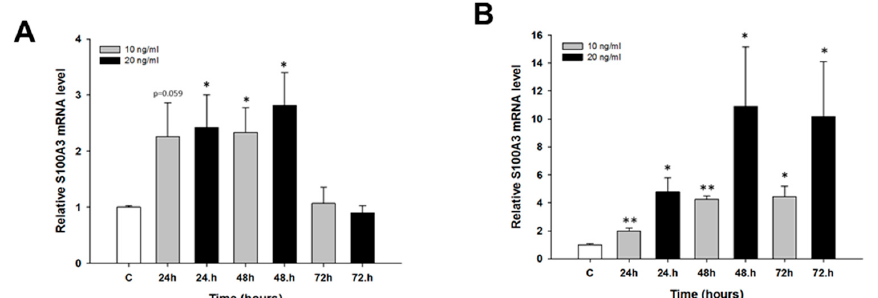
control (white bars), assigned as 1. The values were considered significant at * p < 0.05 and ** p < 0.01.